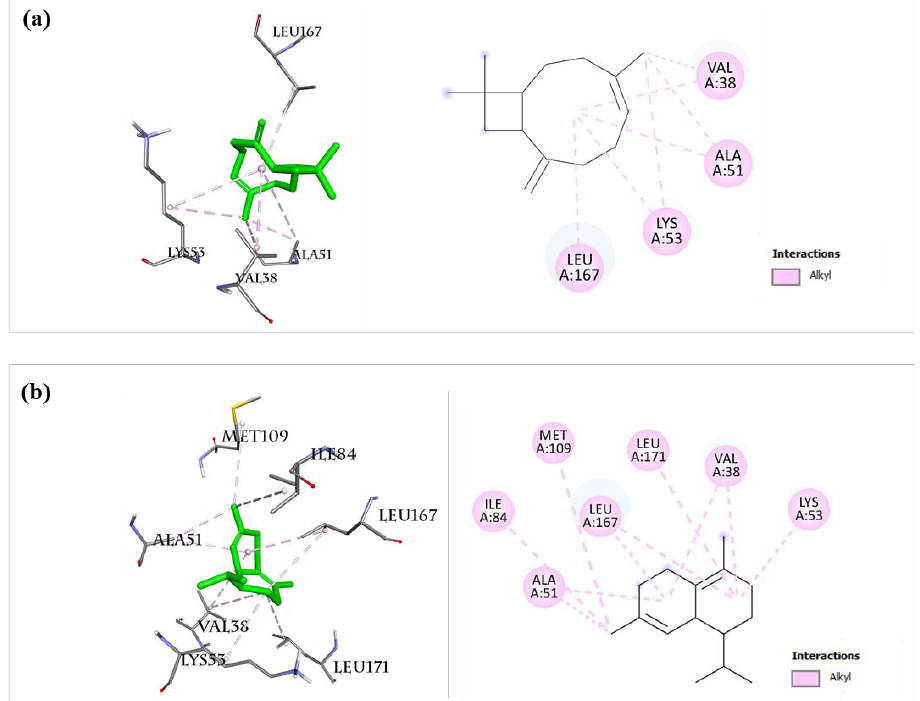
Figure 12. Docking analysis of compounds 16 and 23 with p38MAPK. (a) Compound 16 (left: 3D, right: 2D) showed alkyl interaction with Val38, Ala51, Lys53, and Leu167 residues of p38MAPK (PDB ID: 4FA2). ( b ) Compound 23 (left: 3D, right: 2D) showed alkyl interaction with Val38, Ala51, Lys53, Ile84, Met109, Leu167, and Leu171 residues of p38MAPK (PDB ID: 4FA2).